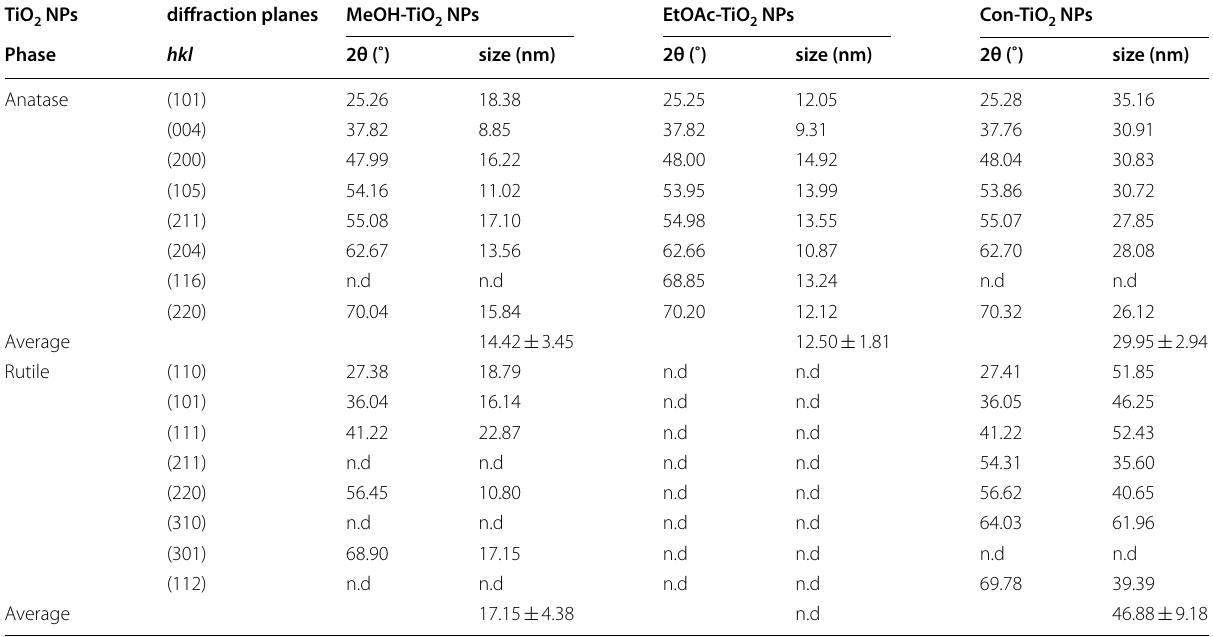
n.d.: not detected